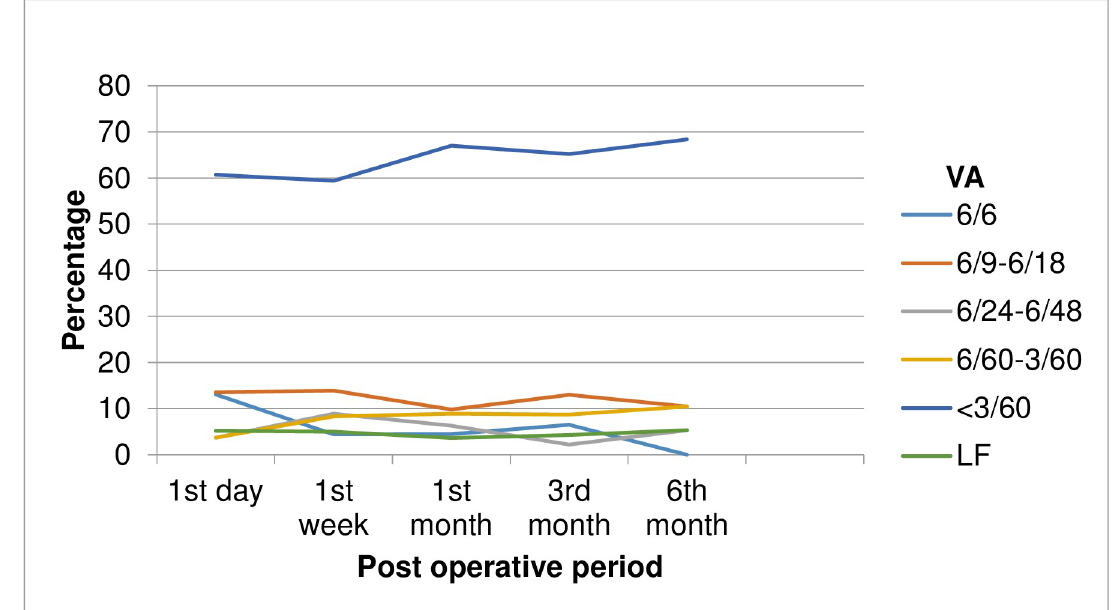
Fig 4. Post treatment VA of ocular traumatic patients at Hawassa University, Referral Hospital, from January 01, 2012 to July 31, 2014. VA, visual acuity; LF, light follow.